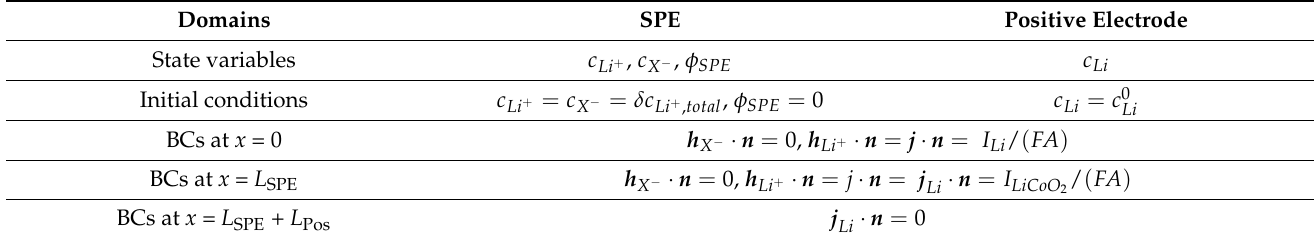
Figure 2. Effect of aging time on ionic conductivity of SPE with different lithium salt contents (20 °C). Table 1. State variables and initial and boundary conditions (BCs) for the electrochemical model.